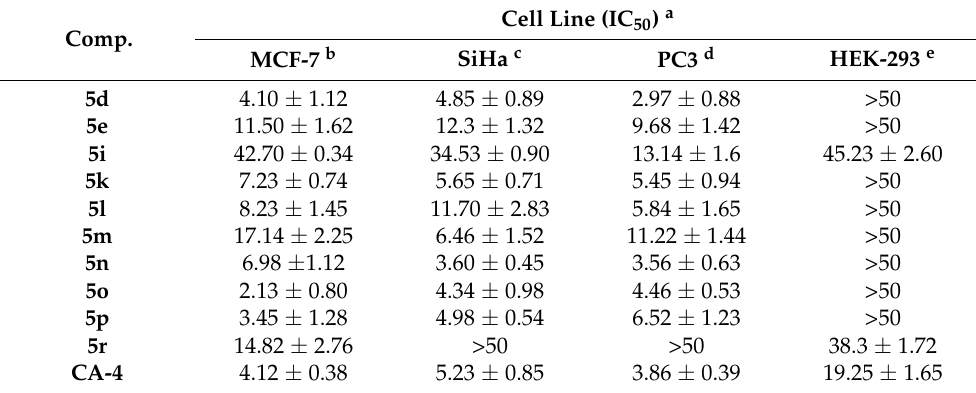
experiments performed in triplicates. b Breast cancer, c cervical cancer, d prostate cancer cell line, and e human normal cell line CA-4: Combretastatin A-4.